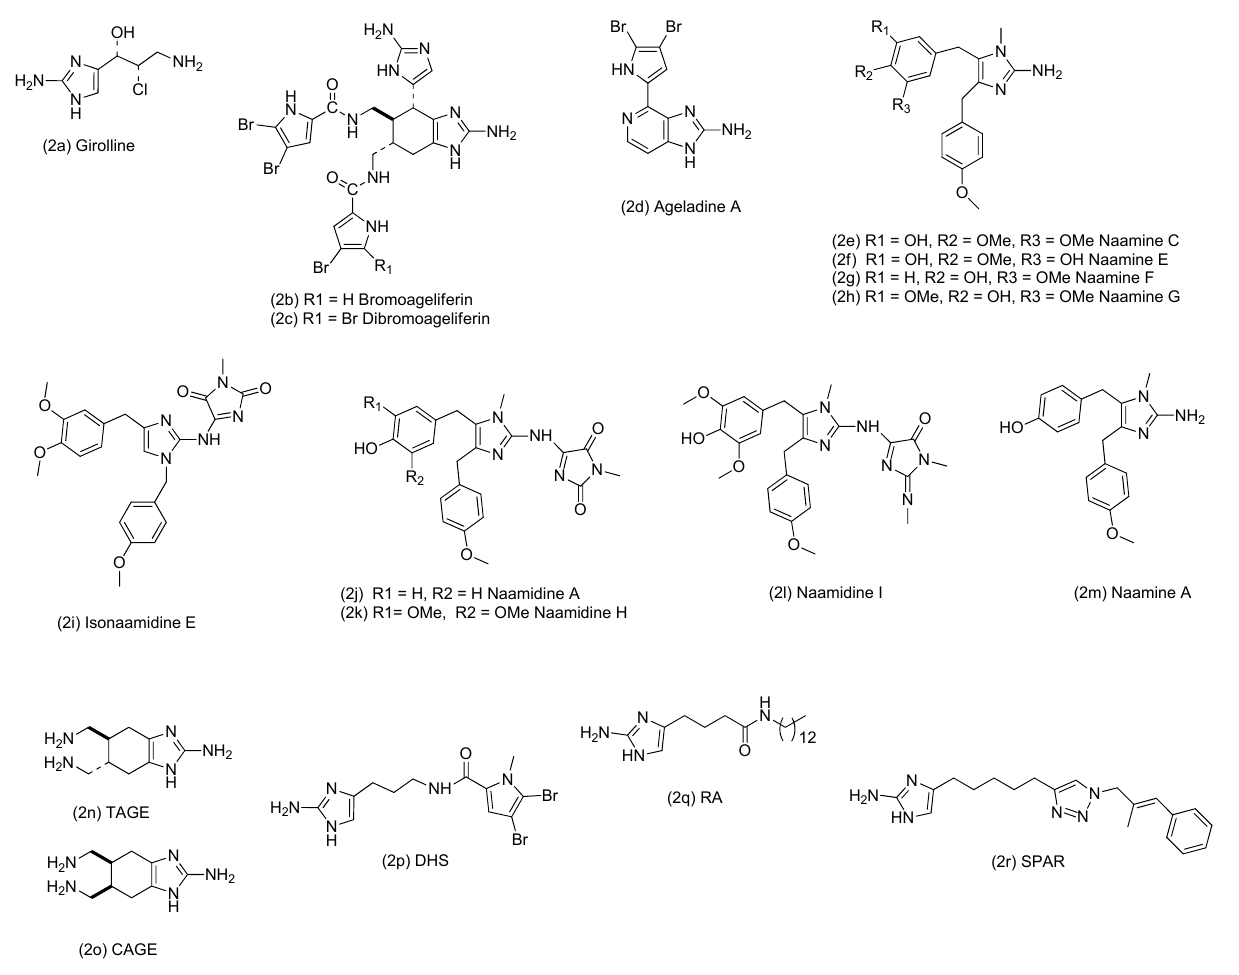
Figure 2. Structures of 2-aminoimidazole (2AI) based compounds, previously tested for